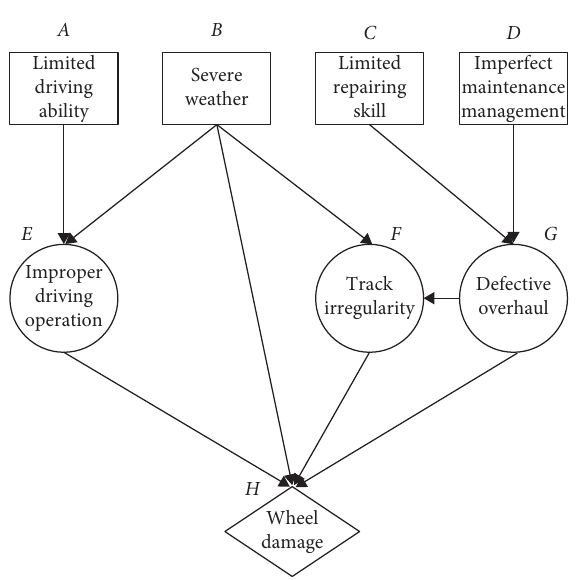
Figure 5: The general structure of the proposed ID